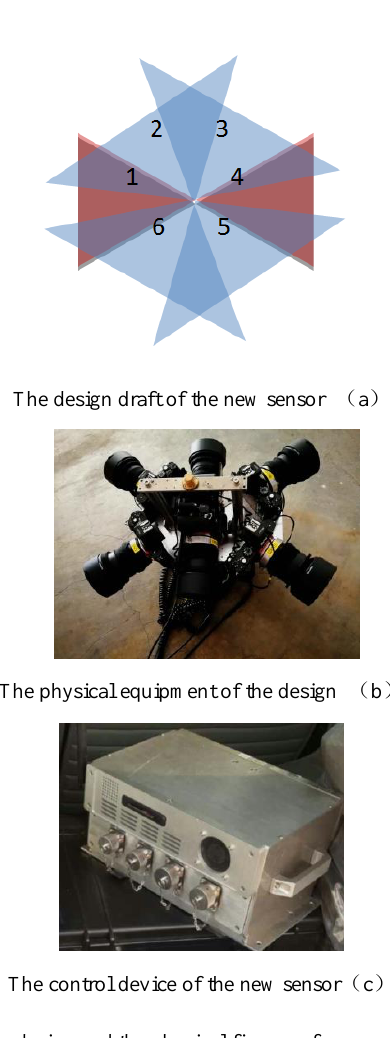
Figure 2 The design and the physical figures of our new device After some experiment, we chose six cameras to set up the new device. No.1 camera is defined as the left camera and No. 2 camera is defined as the left front camera. No.3 camera is defined as the right front camera and No. 4 camera is defined as the right camera. No.5 camera is the right back camera, and No.6 camera is defined as the left back camera. According to the photogrammetry principle, the overlap between two adjacent cameras is not less than 30%. to acquire the modeling data , the new device is installed on the vehicle top. And the images overlap between the directions of the left or right camera is around 80%, and a certain sampling interval is set to ensure this